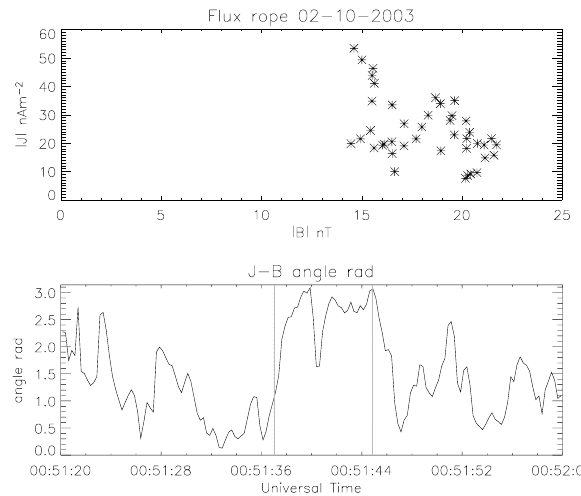
Fig. 9. | J | versus | B | and the angle (in radians) between the mag- netic field and current density vectors for the 2 October 2003 flux rope. For a constant α force-free flux rope | J | would be proportional to | B | and the magnetic field and current density vectors would be